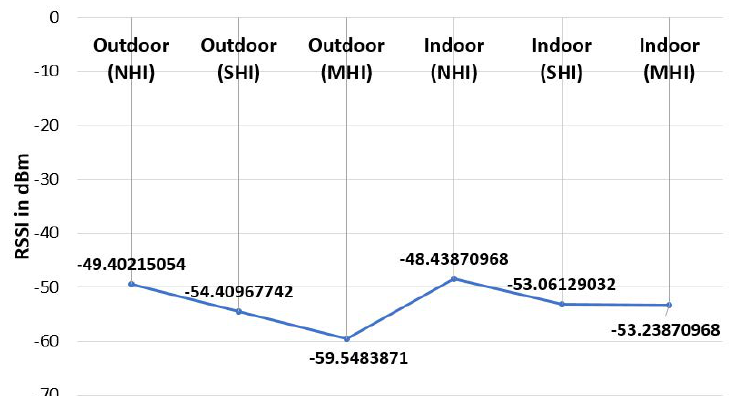
Figure 19. Outdoor average RSSI.